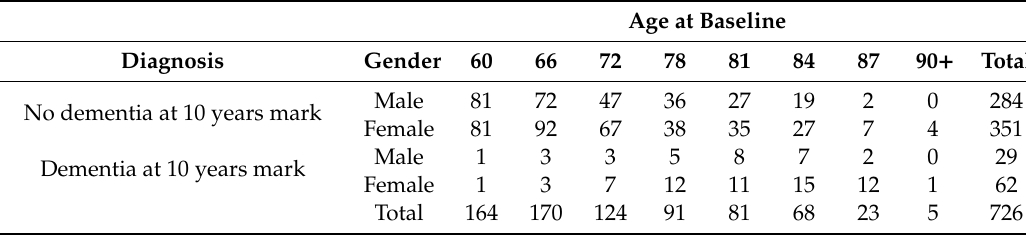
Table 1. Demographics of the study